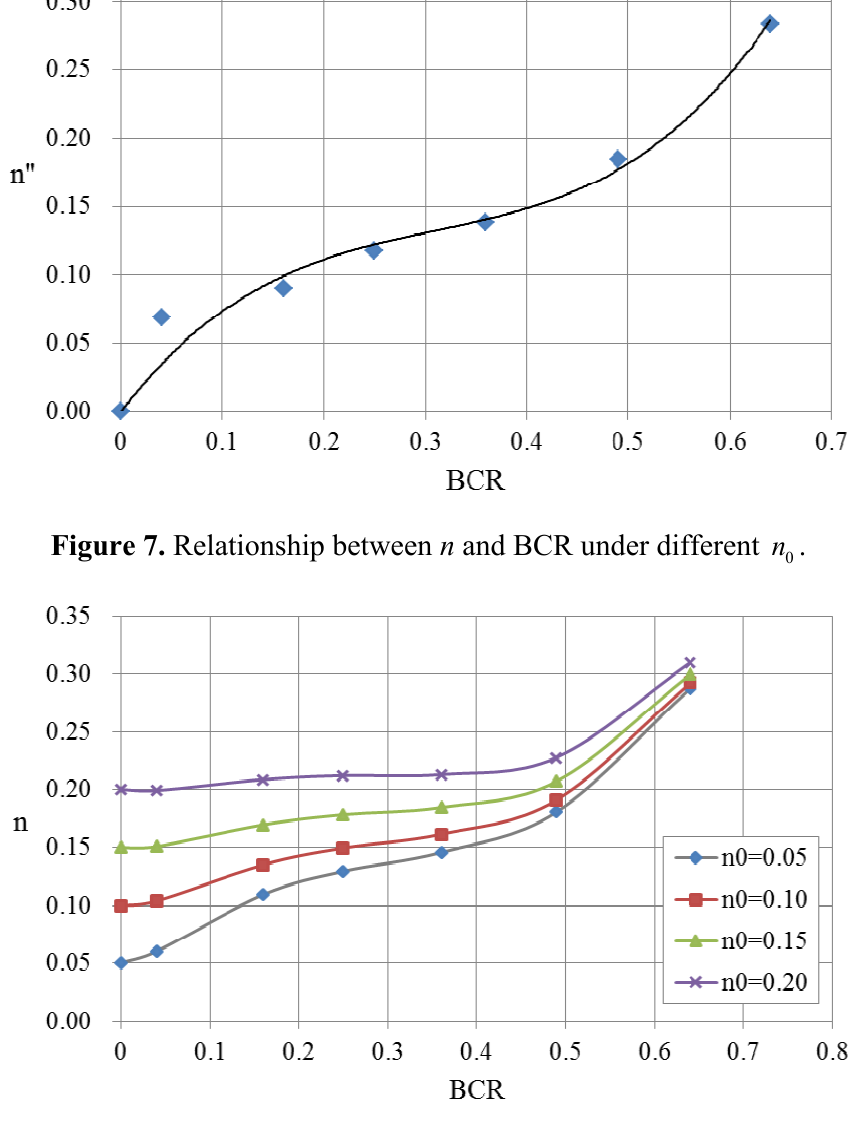
Figure 6. Relationship between n" and BCR.